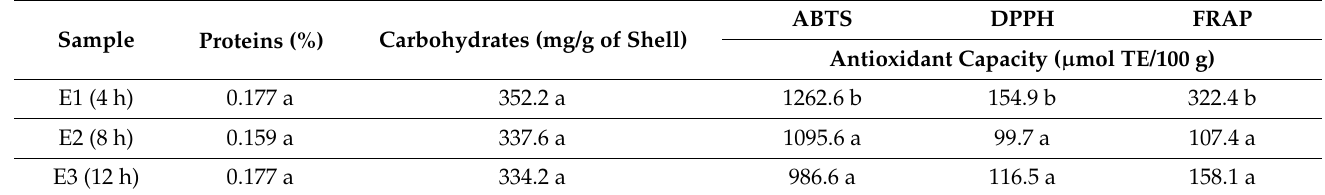
Table 1. Protein, carbohydrates content and antioxidant capacity of pecan nut shell